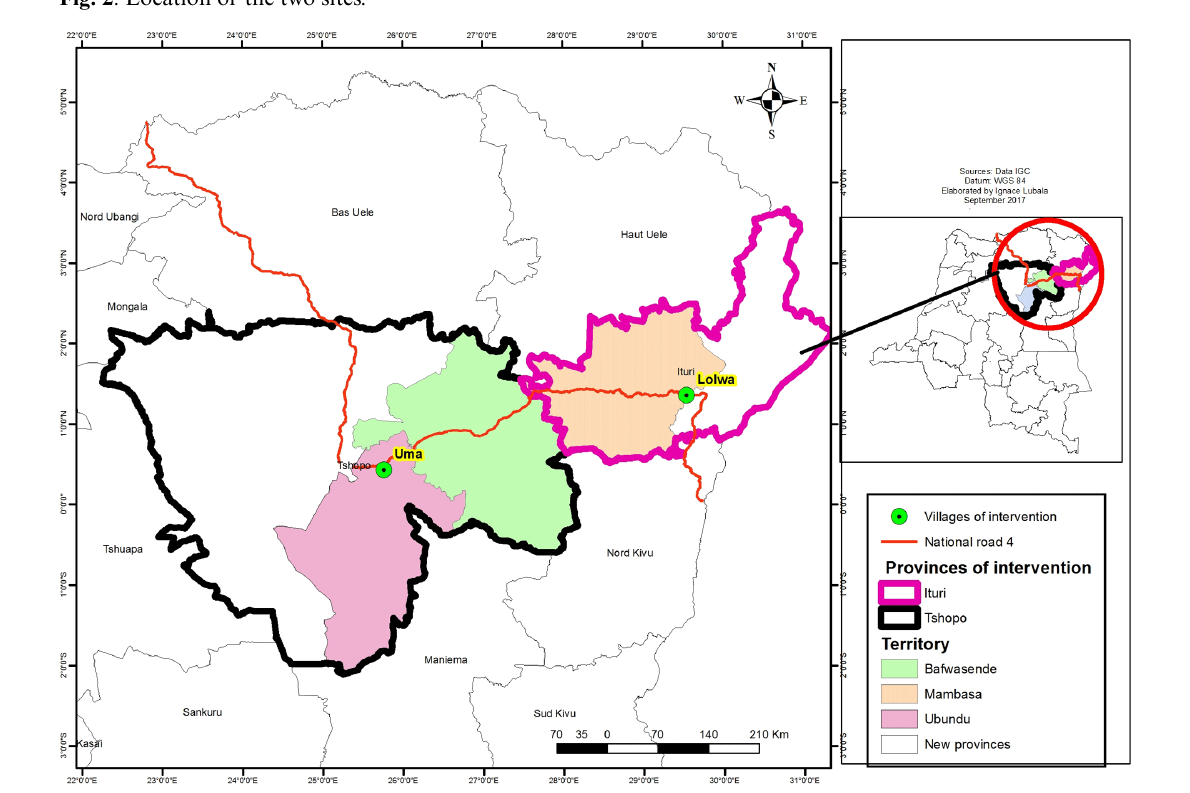
Fig. 2 . Location of the two